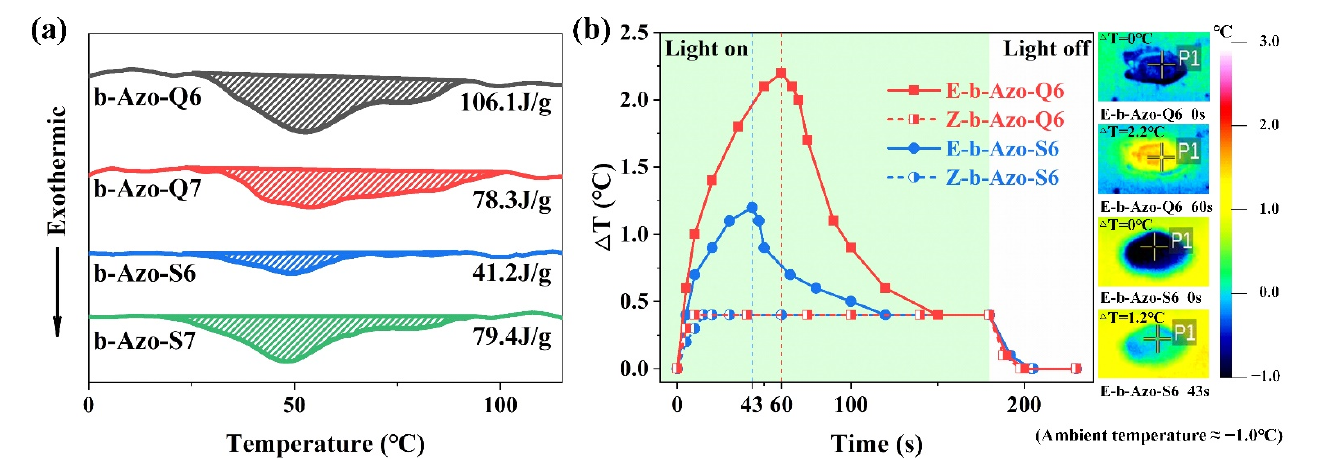
Figure 3. ( a ) DSC exothermic curves for the four charged b-Azo chromophores between 0 and 110 °C at a heating rate of 2 °C/min; ( b ) ΔT versus time graphs for the exothermic discharge processes of b-Azo-Q6 and b-Azo-S6, and infrared thermal images at several time points. P1 is the highest temperature inside the sample. The ambient temperature is −1 °C.